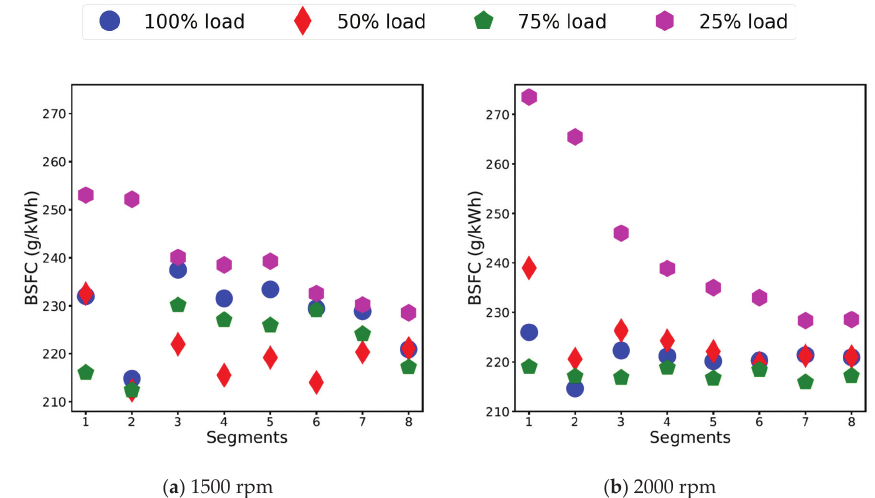
Figure 11. Brake specific fuel consumption (BSFC) at each load in each segment at ( a ) 1500 and ( b ) 2000 rpm. The blue circle represents 100% load, the red diamond 50% load, the green pentagon 75% load and the pink hexagon 25% load.